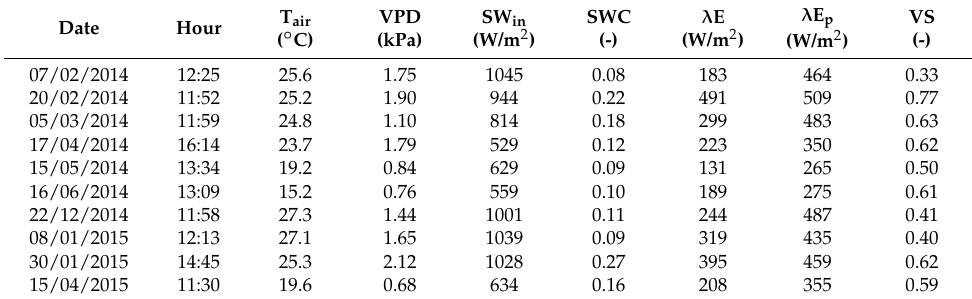
Table 1. Overview of the meteorological and soil moisture conditions during the 10 flights, obtained from the flux tower measurements. The time reflects the start of the UAV flight.